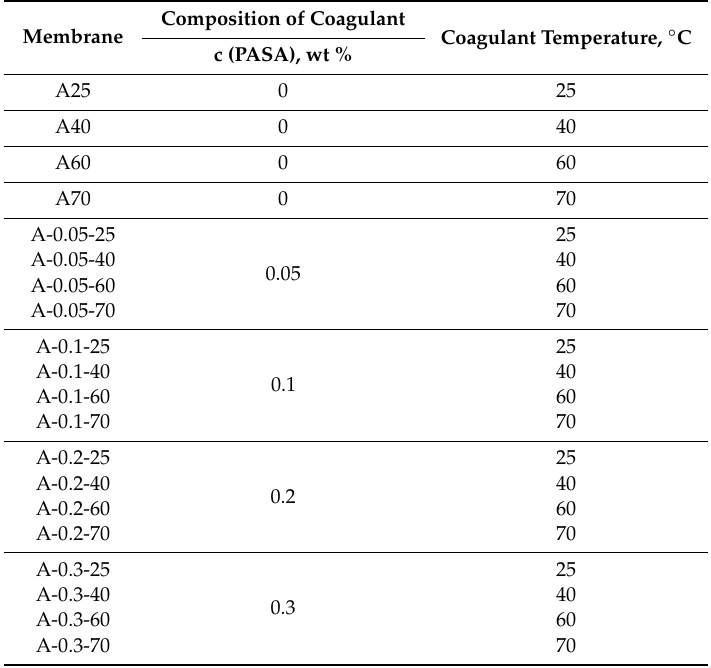
Table 1. Composition and temperature of coagulant during membrane